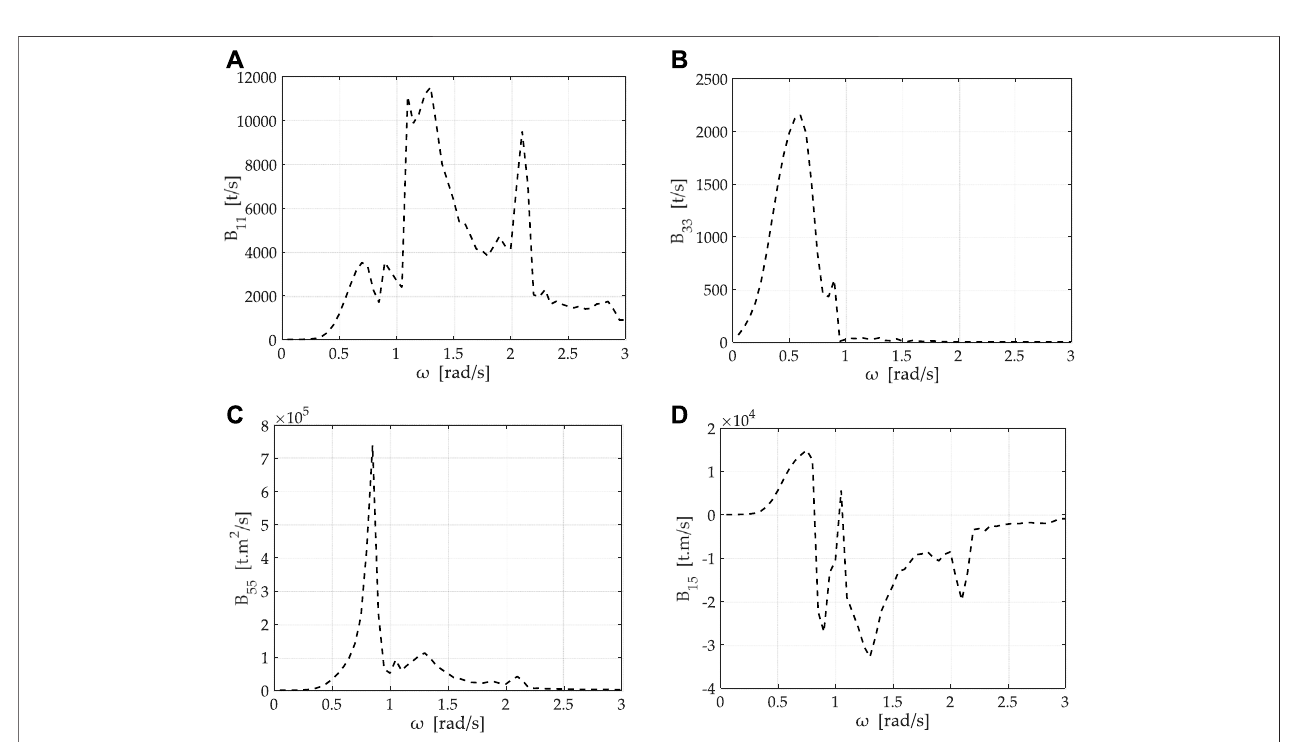
FIGURE 7 | Hydrodynamic damping coef fi cients of the hybrid structure versus wave frequency: (A) B 11 , (B) B 33 , (C) B 55 , (D) B 15 .